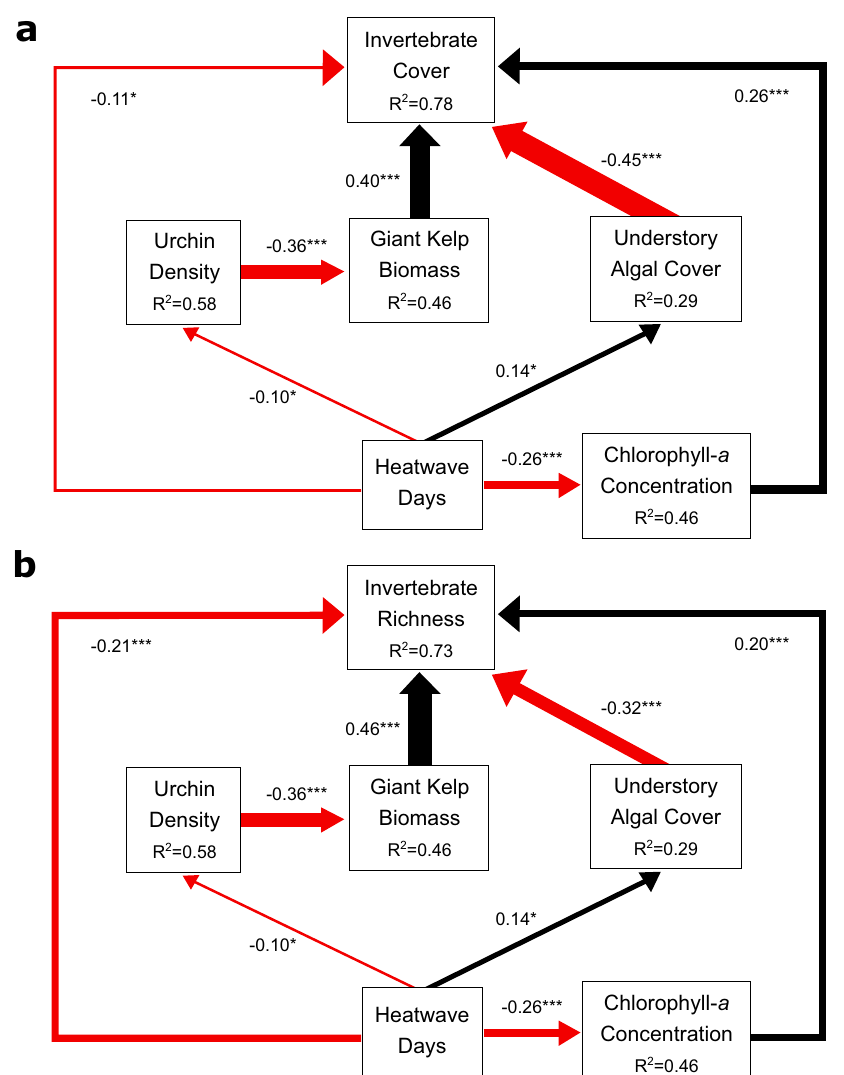
Fig. 2 Piecewise structural equation modeling (SEM) for sessile invertebrate cover and species richness. Arrows indicate directionality of effects on ( a ) invertebrate cover and ( b ) species richness. Red arrows show negative relationships; black arrows show positive relationships. R 2 values are conditional R 2 . Arrow widths are proportional to effect sizes as measured by standardized regression coef fi cients (shown next to arrows). *** p < 0.001, ** p < 0.01, * p < 0.05. Insigni fi cant pathways are not